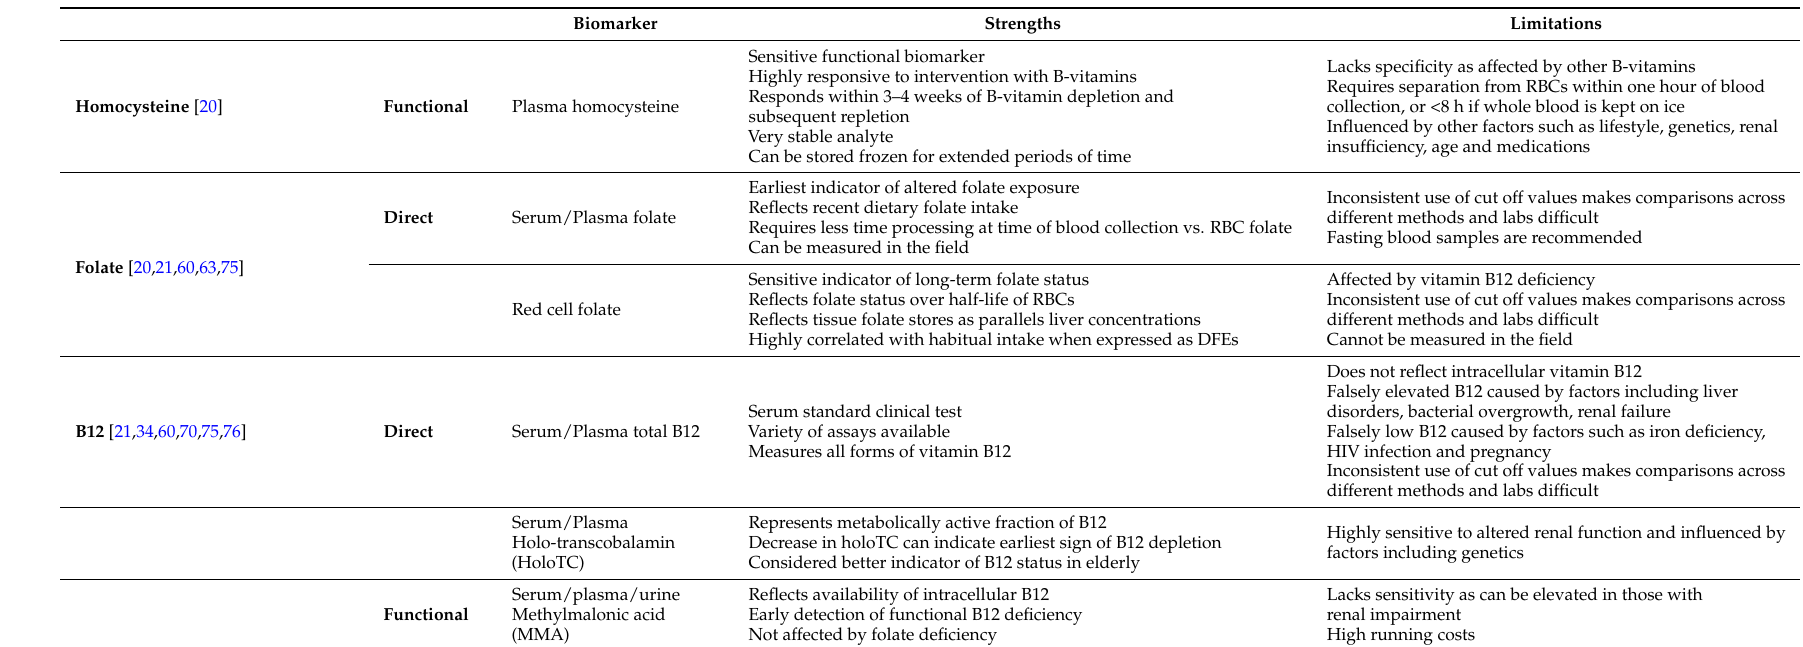
Table 2. Assessment of B-vitamin biomarker